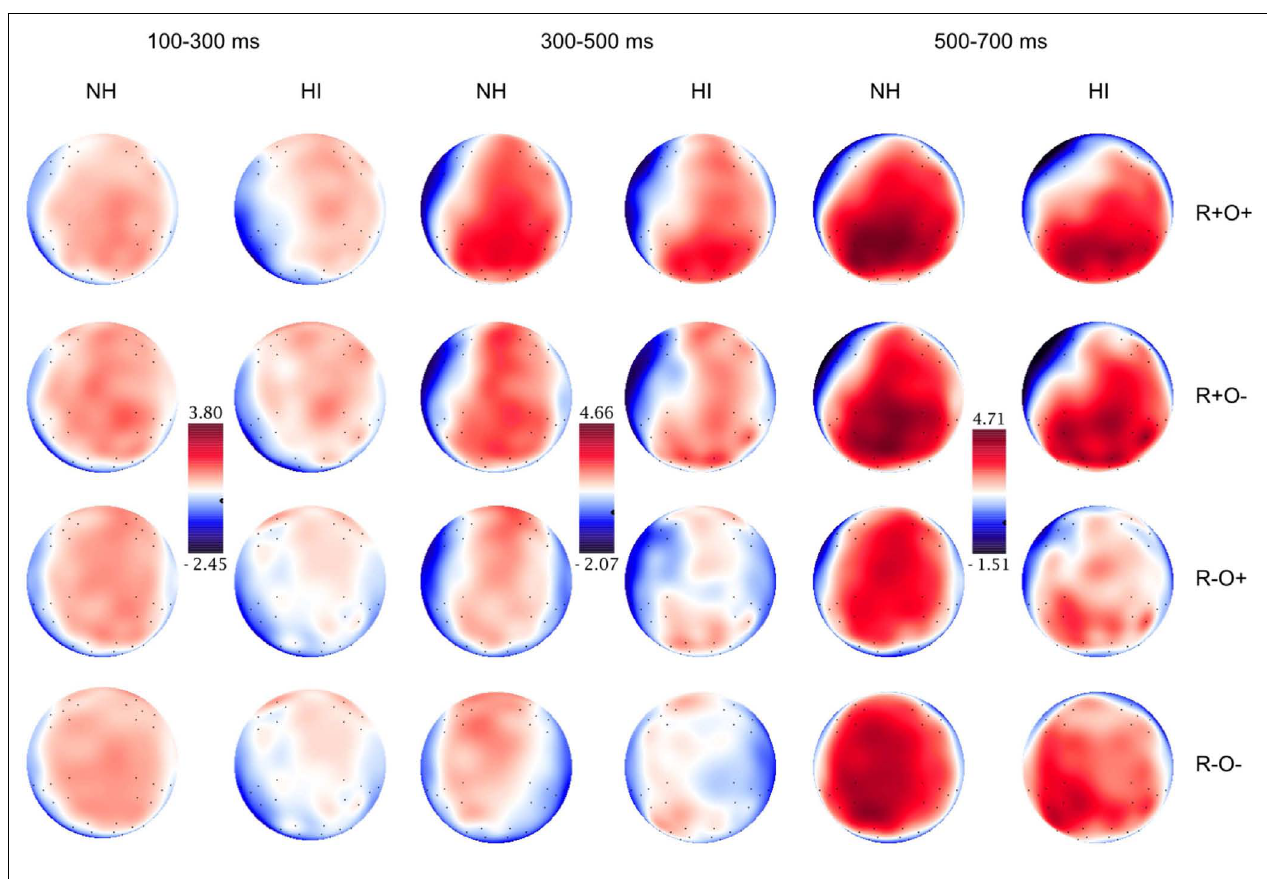
FIGURE 6 |Topographical distribution of the grand averaged ERPs in the normal hearing (NH) and hearing-impaired (HI) groups in the 100–300, 300–500, and